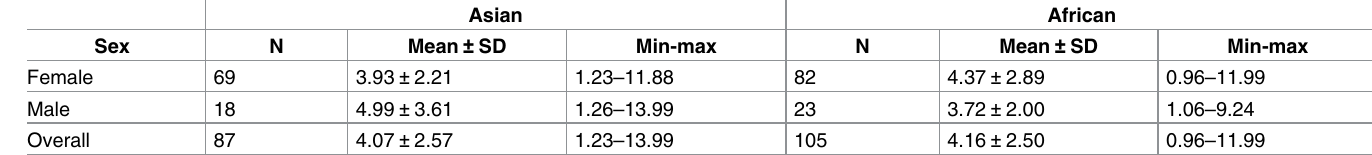
Table 2. Mean ± SD and range of leptin concentrations (ng/ml) in male and female Asian and African elephants.